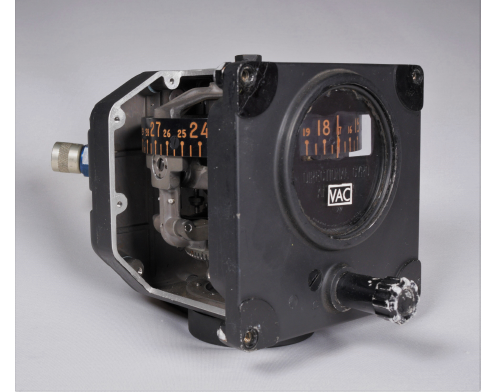
Figure 3. Original image of the Ternstedt directional gyro